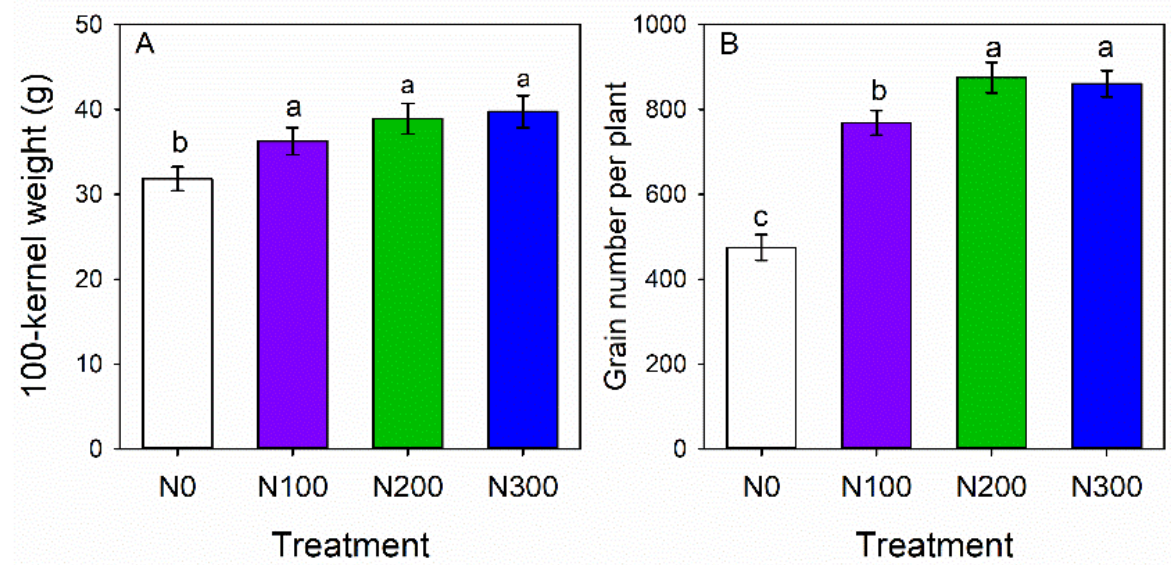
Figure 5. Average 100-kernel weight ( A ) and grain number per plant ( B ) as affected by nitrogen rate in 2012 − 2016. Error bars indicate standard deviations of the means. For a given dependent variable, different letters indicate treatment means that are significantly different ( p ≤ 0.05). The nitrogen × year interaction was not statistically significant for 100-kernel weight, grain number per plant, and grain yield per plant. Table 3. Effects of four rates of nitrogen (N) application and growing seasons on biomass accumula- tion, grain yield, and harvest index of